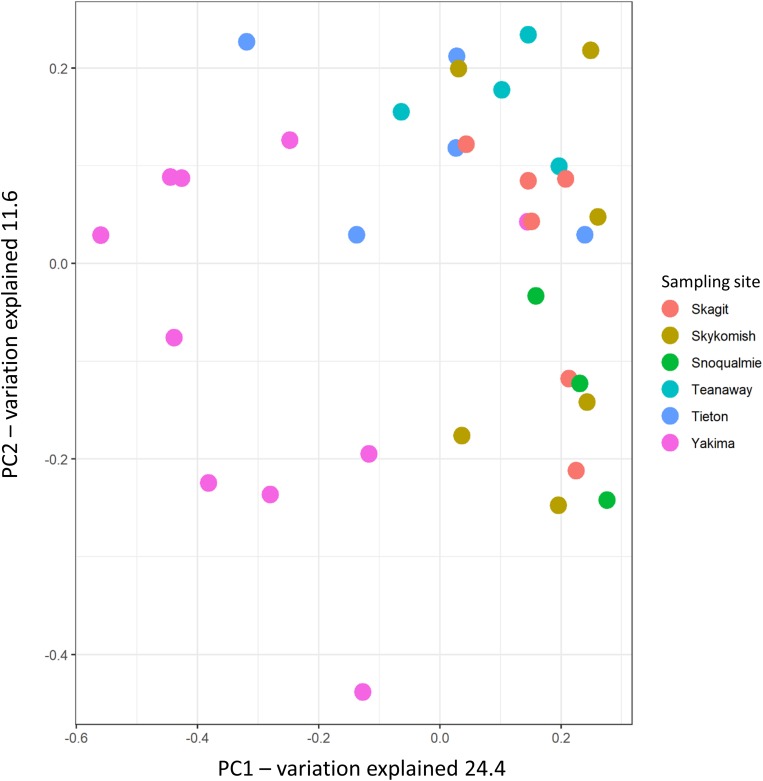
Principal coordinate analysis of phyllosphere endophytic microbial communities using Bray-Curtis distances. Circles represent samples.